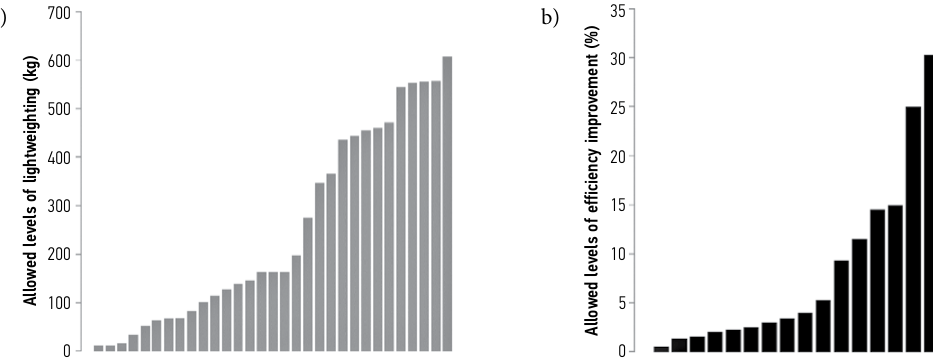
Fig. 13. Allowed levels of technology implementation: lightweighting (a) efficiency (b)